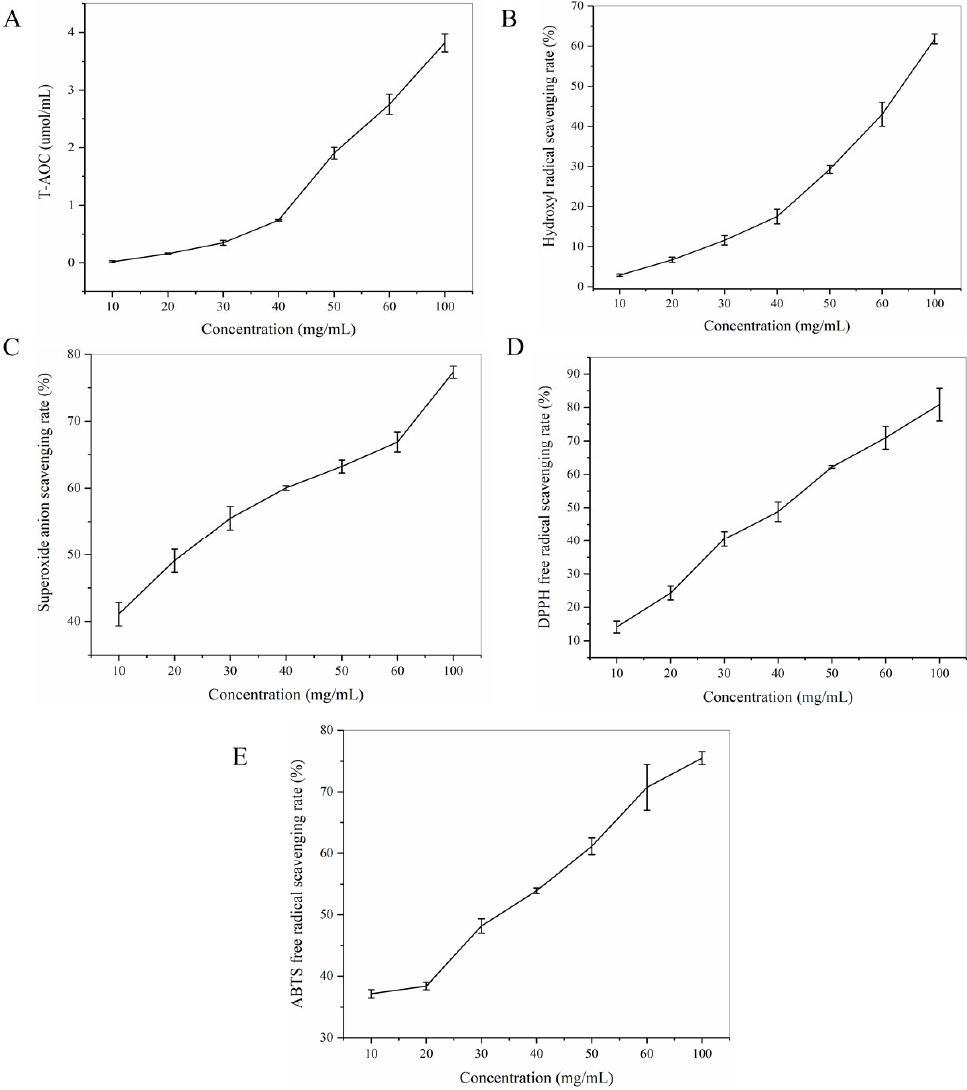
Figure 1. Antioxidant activity of HGP in vitro. ( A ) Total antioxidant capacity (T ‐ AOC) of HGP. ( B ) Hydroxyl radical scavenging rate of HGP. ( C ) Superoxide anion scavenging rate of HGP. ( D ) DPPH radical scavenging rate of HGP. ( E ) ABTS radical scavenging rate of HGP. Results expressed as mean ± standard deviation ( n = 3). Table 1. Antioxidant activity of vitamin C in vitro.